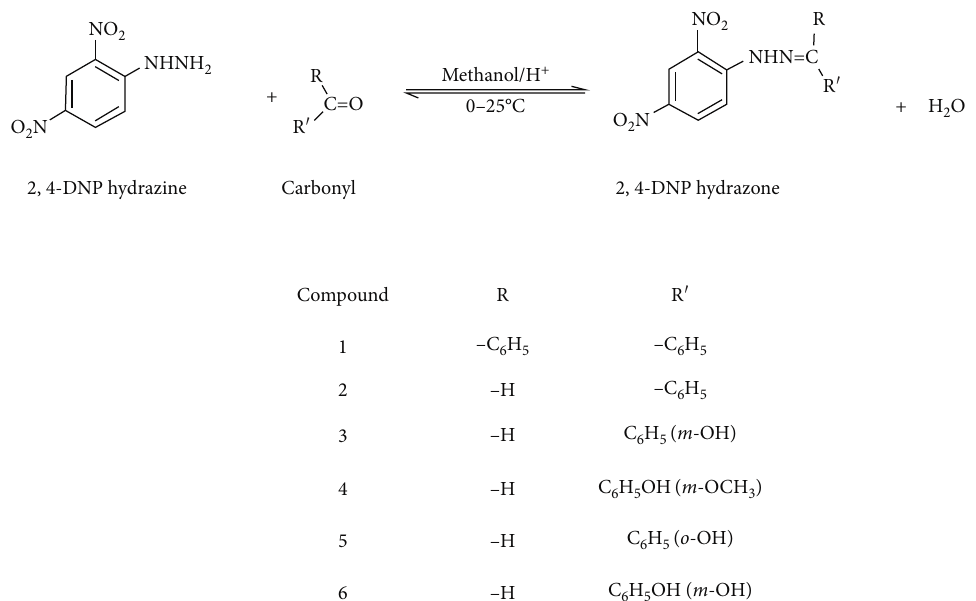
Scheme 1: Synthetic procedures and reagents for compounds 1–6. Reagents and conditions: methanol/concentrated H 0–25 ° C,